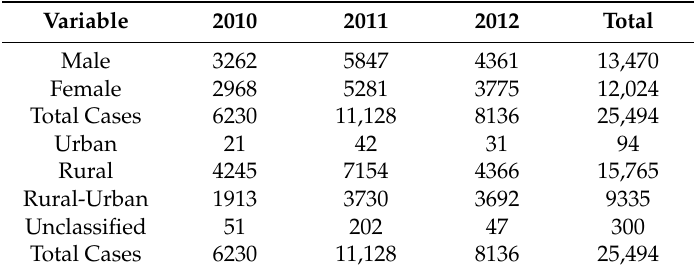
Table 1. Incidence and socio-demographic characteristics of pediatric malaria patients in Burundi, 2010 to 2012.